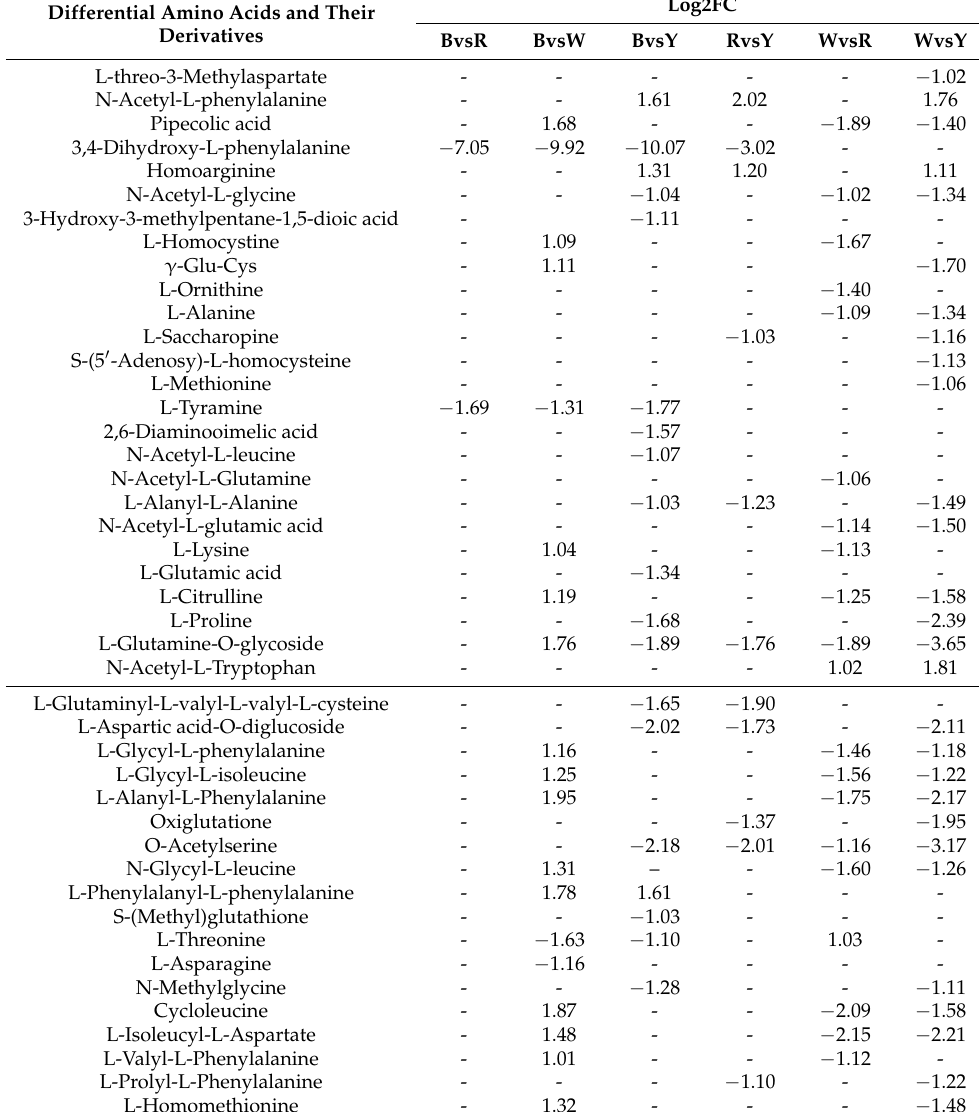
Isoxanthopterin was upregulated, whereas the other 11 were downregulated. Table 1. Analysis of differences of amino-acid-related metabolites in quinoa seeds of different cultivars. Differential Amino Acids and Their